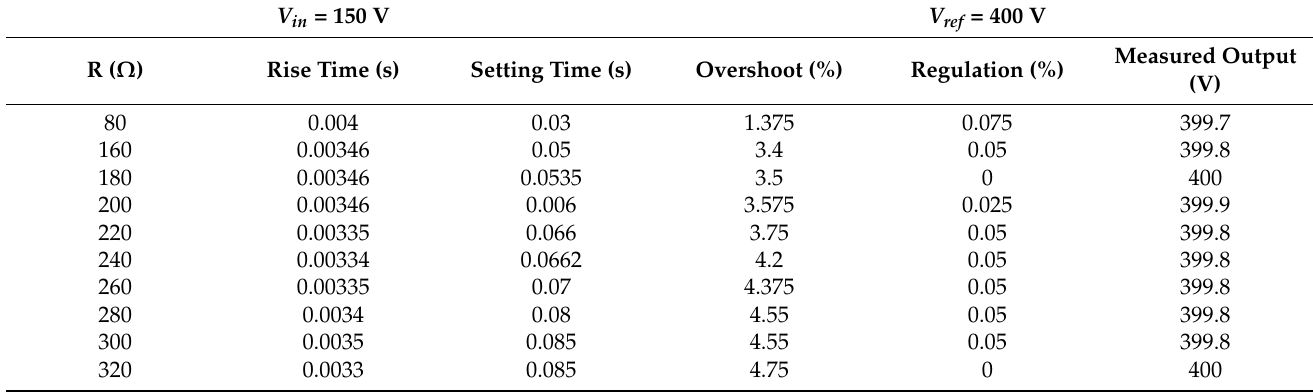
Table 3. Performance parameters of proposed HG-SIQBC for V in = 150 V.